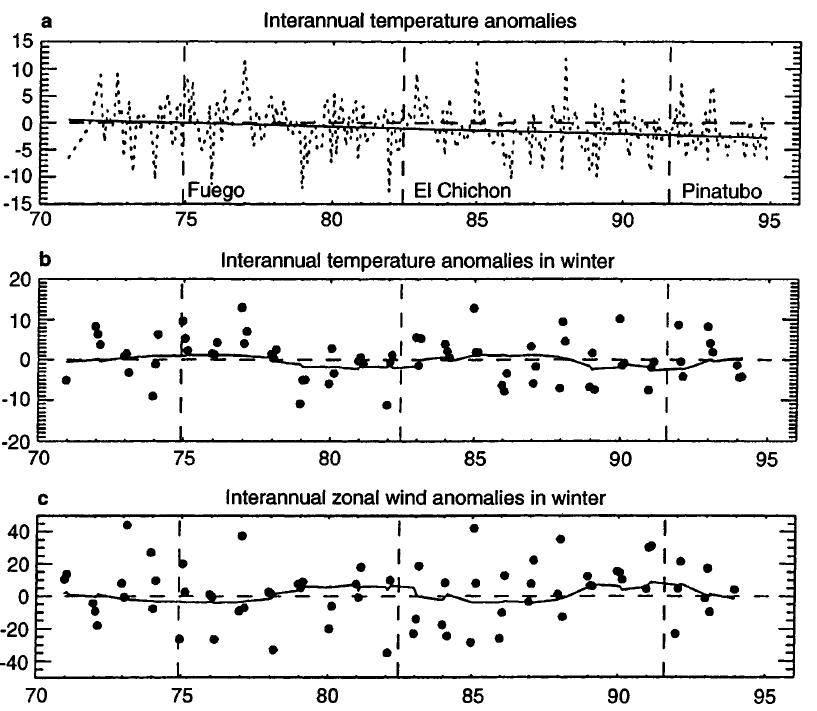
Fig. 4. Data series of the anomalies (data minus seasonal changes) at 40 km over Ryori for temperature a for all the data, b for winter temperature only and c for winter zonal wind. Solid lines in b show linear trend or b, c solar cycle response computed by the